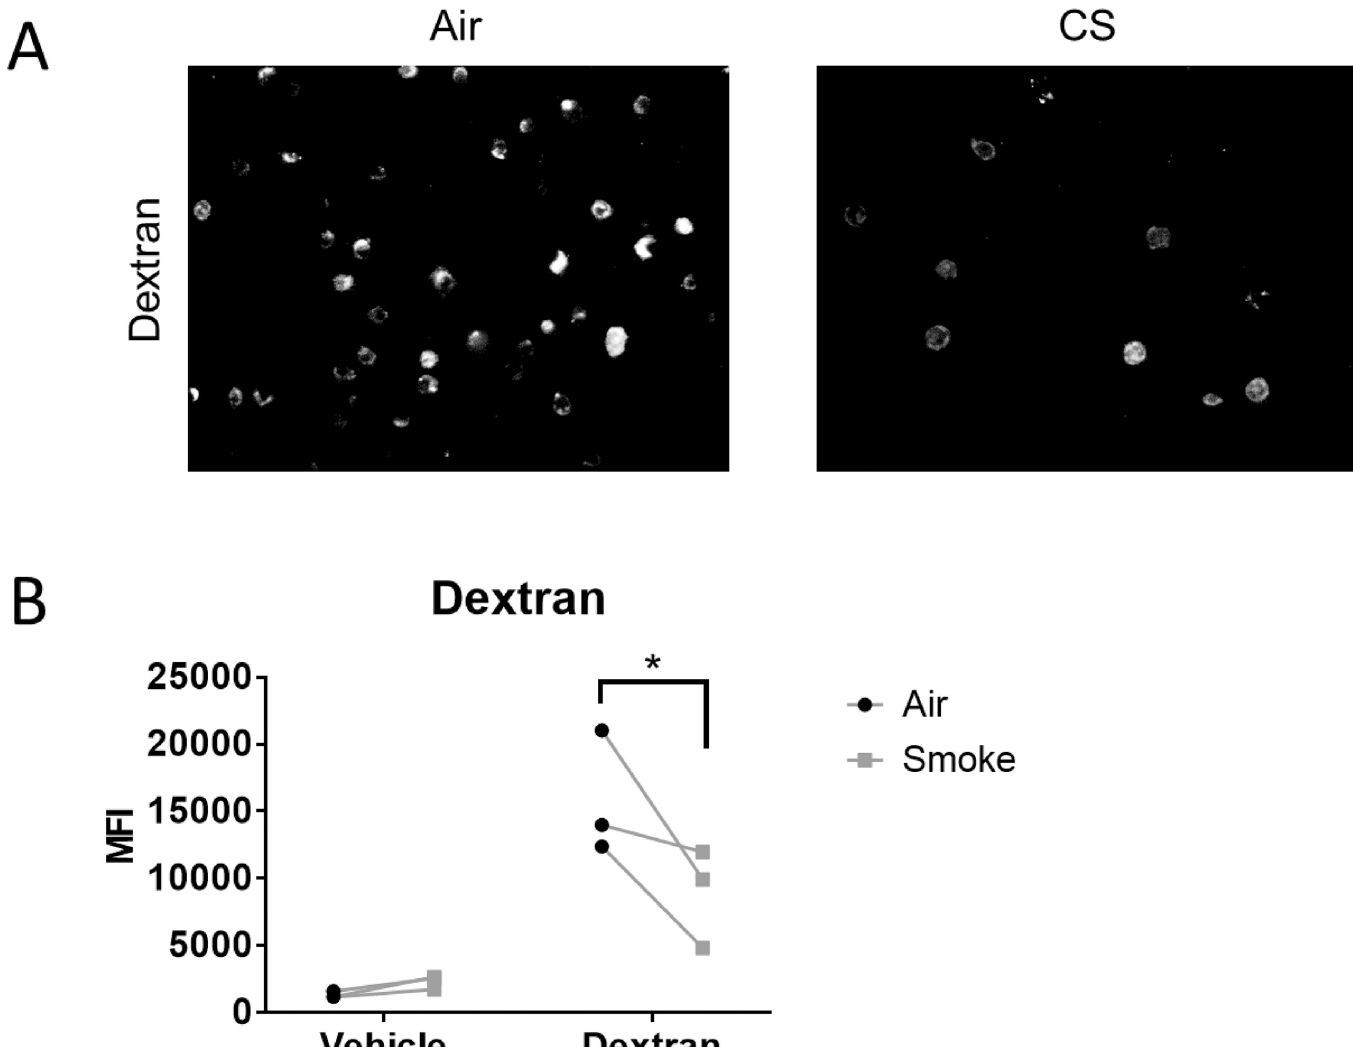
Fig 5. Cigarette smoke decreases macropinoctosis. Primary human SAEC were exposed to either air or cigarette smoke for 60 minutes at the air-liquid interface. Following exposure cells were treated with FITC-dextran (250 μ g/mL) as described in the materials and methods. (A) Representative photographs from one cell strain. All three SAEC strains showed similar results. (B) Analysis of cell fluorescence by flow cytometry for FITC-dextran uptake. Each pair of points represents an SAEC strain from a different donor. � p < 0.05 by two way ANOVA with Sidak correction.